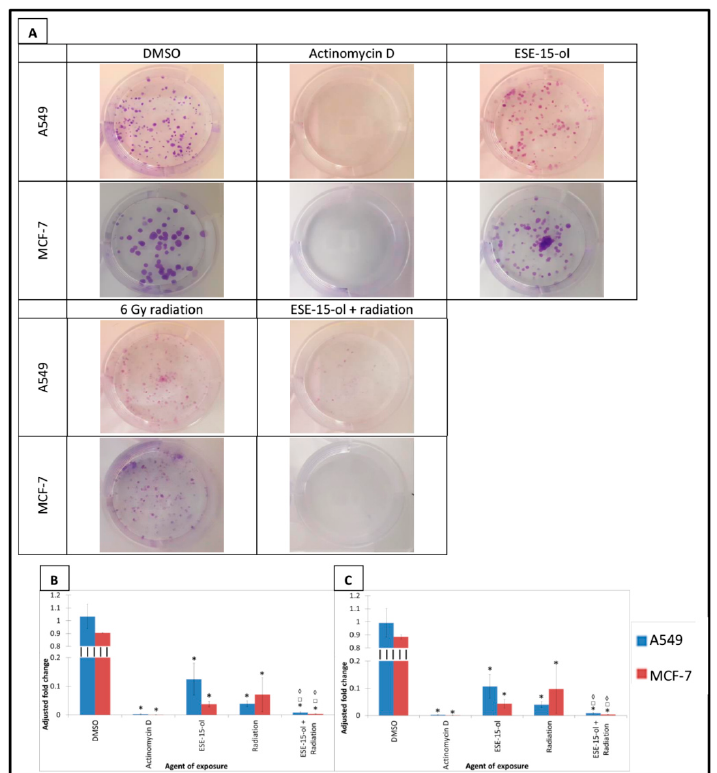
Figure 5. Clonogenic studies of treated A549- and MCF-7 cells. ( A ) Colony formation of A549- and MCF-7 cells exposed to ESE-15-ol for 24-h, 6 Gy radiation, and the combination treatment condition. DMSO served as a vehicle control and actinomycin D as a positive control for apoptosis. Colony formation decreased in all treatment conditions. ( B ) Graphical representations of area percentage covered by A549- and MCF-7 cells. ( C ) Graphical representation of intensity of A549- and MCF-7 colonies. Bars indicate the average of three biological repeats, with standard deviation represented by T-bars. Statistical significance ( p -value < 0.05) represented by * when compared to DMSO, □ when compared to ESE-15-ol treated samples, ◊ when compared to the radiation treated samples.